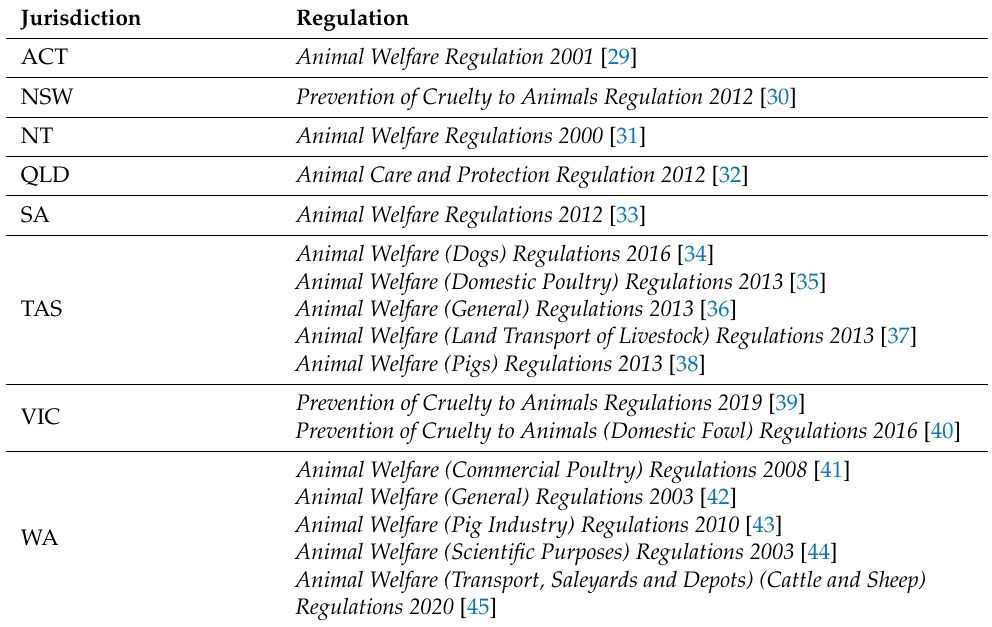
Table 2. Subordinate legislation in the form of regulations made under animal welfare statutes for each Australian state and